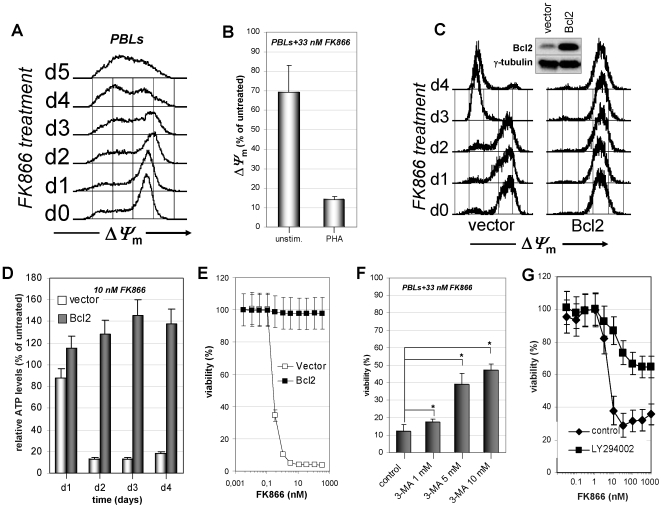
Nampt inhibition with FK866 induces mitochondria depolarization and ATP depletion in activated T lymphocytes.A, PHA- stimulated PBLs were incubated with 33 nM FK866 and ΔΨ
m was determined at the indicated days of exposure. B, Resting of PHA-stimulated PBLs were cultured with 33 nM FK866 for five days. Thereafter PBLs with conserved ΔΨ
m-high were quantified by flow-cytometry. C, Bcl2-overexpressing Jurkat and the respective vector control cells were incubated with 10 nM FK866 for the indicated number of days. Thereafter, ΔΨ
m was determined. Inset, Western blot for Bcl2 and γ-tubulin expression. D, 5×105 Bcl2-overexpressing Jurkat and the vector control cells were incubated with or without 10 nM FK866 for the indicated times before ATP was detected. ATP levels are presented as % of ATP in FK866-untreated cells. E, 3×104 Bcl2-overexpressing and control Jurkat cells/well were incubated in 96-well plates with or without the indicated FK866 concentrations. Viability was determined by PI staining and flow cytometry 96 h later. F, PHA-stimulated PBLs were incubated in the presence or absence of 33 nM FK866 with or without the indicated concentrations of 3-MA. Viability was detected after five days. *, p<0.05. G, PBLs incubated in 96-well plates in the presence of 5 µg/ml PHA were treated for five days with the indicated FK866 concentrations in the presence or absence of 20 µM LY294002. Viability was subsequently determined by PI staining and flow cytometry. B, Results are presented as means ± SD of three experiments (B, D–G). Panels A and C are representative of three separate experiments.